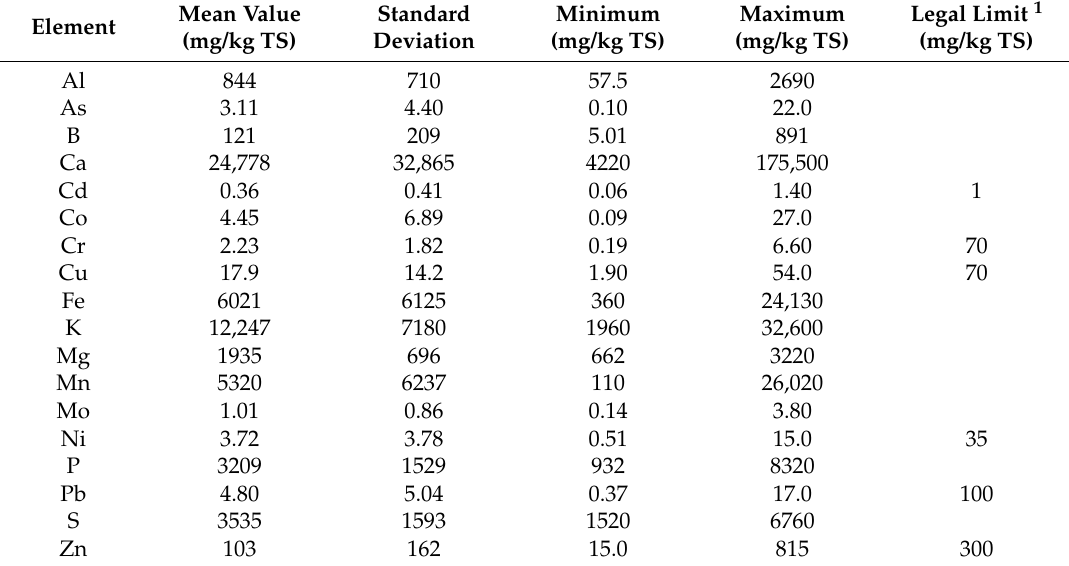
Table 7. Concentrations of elements in plant material in samples from flowing bodies of